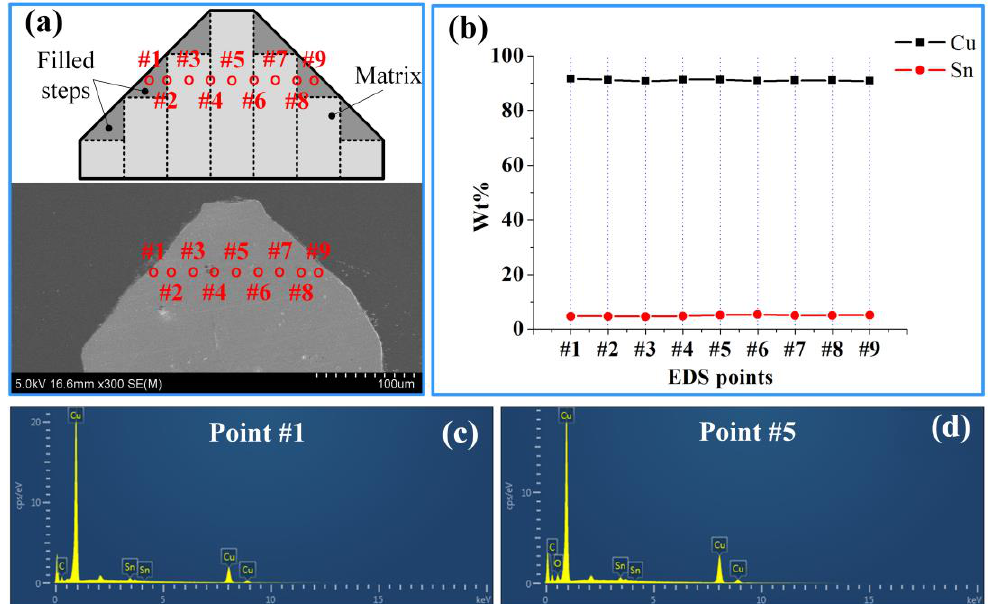
Figure 7. ( a ) Sectional views of microelectrodes; ( b ) The distribution of Cu and Sn along the laminated direction; ( c ) energy dispersive X-ray spectrometer (EDS) result of point #1; ( d ) EDS result of point #5.